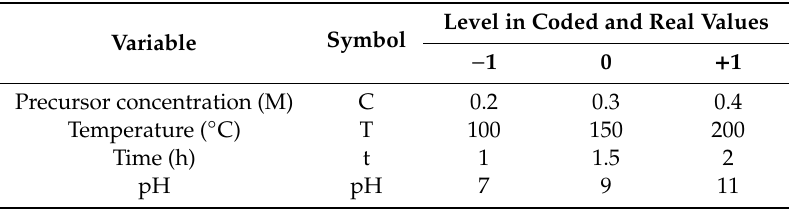
Table 1. Independent variables and their levels used for the central composite design.